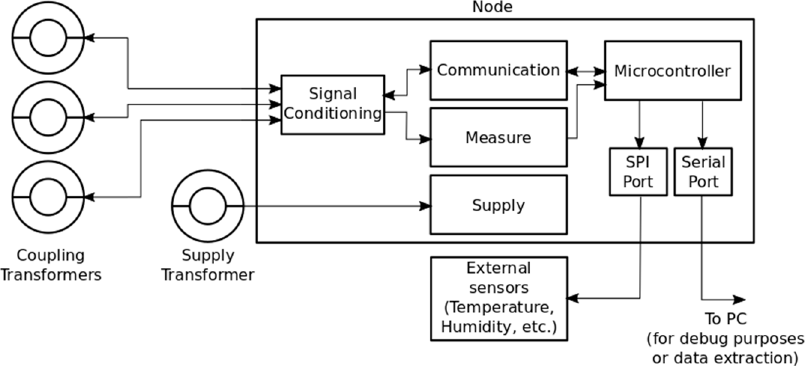
Figure 7. Internal architecture of sensor node.